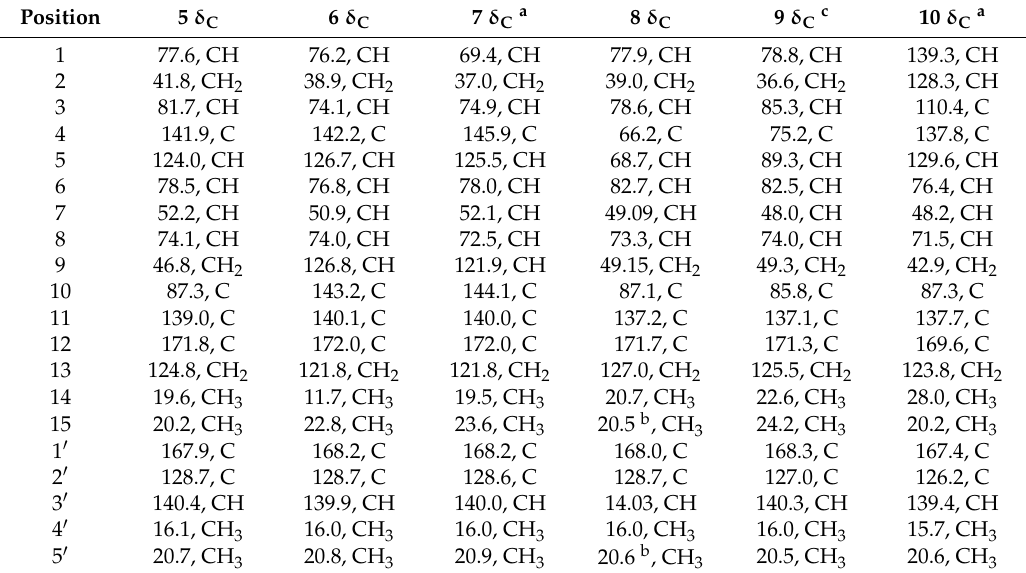
Table 2. 13 C-NMR spectroscopic data for compounds 5 – 8 (CD 3 OD for 5 – 9 , CDCl 3 for 10 ; 125.77 MHz; δ in